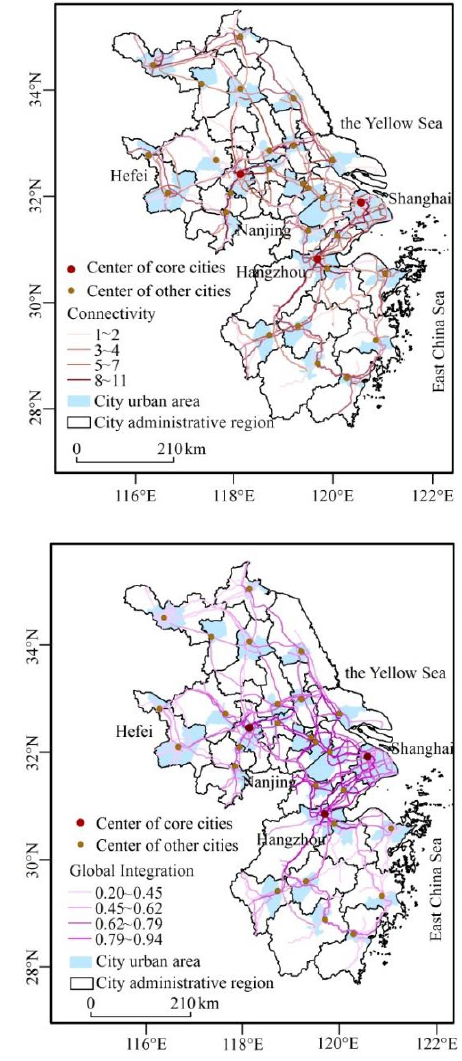
Figure 5. Classification results of space syntax model of road network